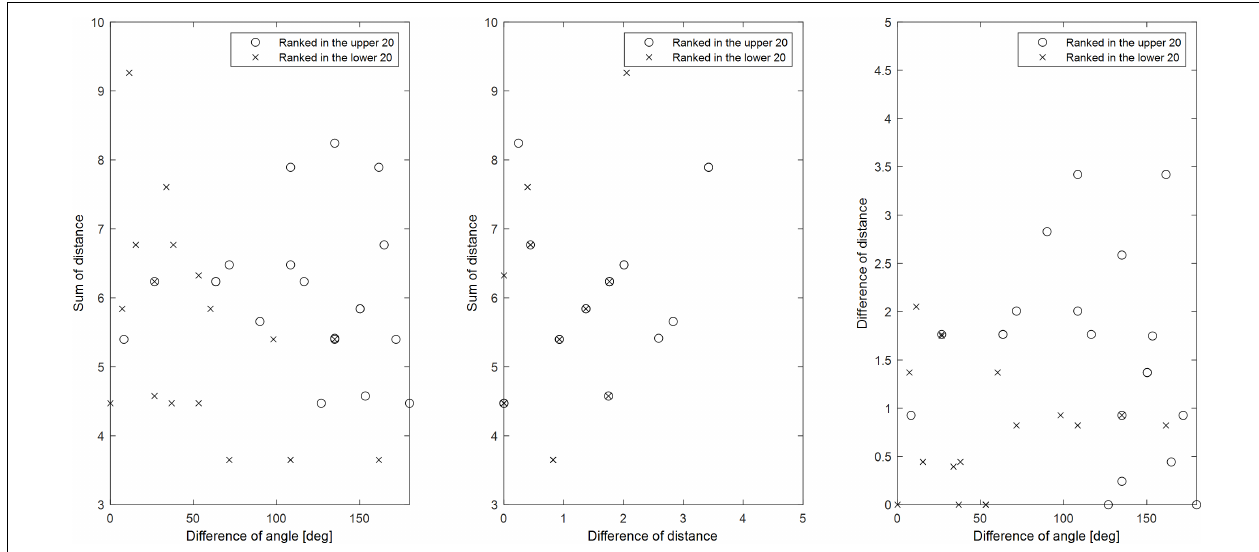
FIGURE 8 | Relationships among parameters comprising two classes for classifications achieving high or low accuracy when all movements were used as different classes. Mean values across all participants were used for sorting accuracy. If the number of features for the individual classification was 0, the classification accuracy was not included in the mean accuracy calculation. When all movements were used as a different class, there were 435 classifications. Based on mean accuracy, circles represent the top 20 among these 435 classifications, while crosses represent the bottom 20. The angle difference, distance difference, and sum of distances comprising each vector representing the class were investigated. Since differences in the direction of the two vectors can have two values, the smaller value was selected (range: 0–180 degrees).